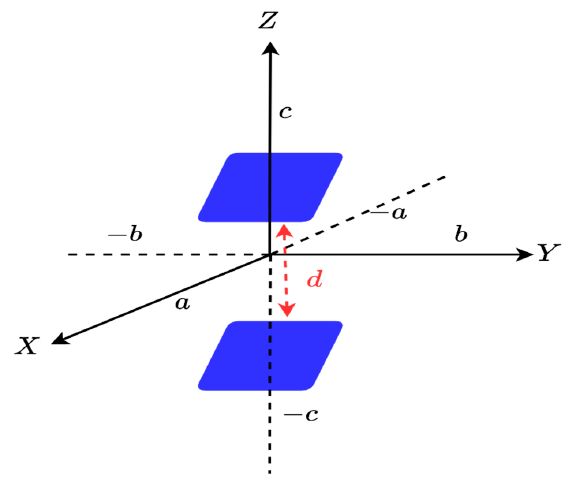
Figure 5. The geometry of two parallel XY faces.